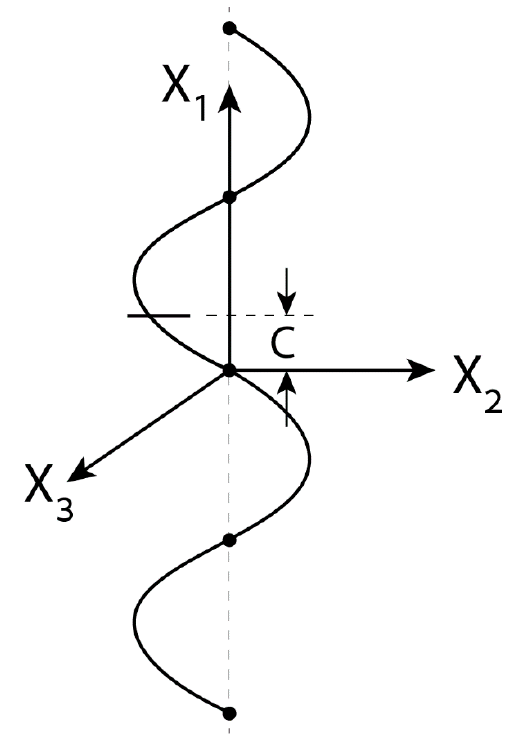
Figure 2. A free polarizable micro/nano NP or JP lying on the x 1 axis ( r = 0) at a distance c from the nearest nodal point of a standing wave.